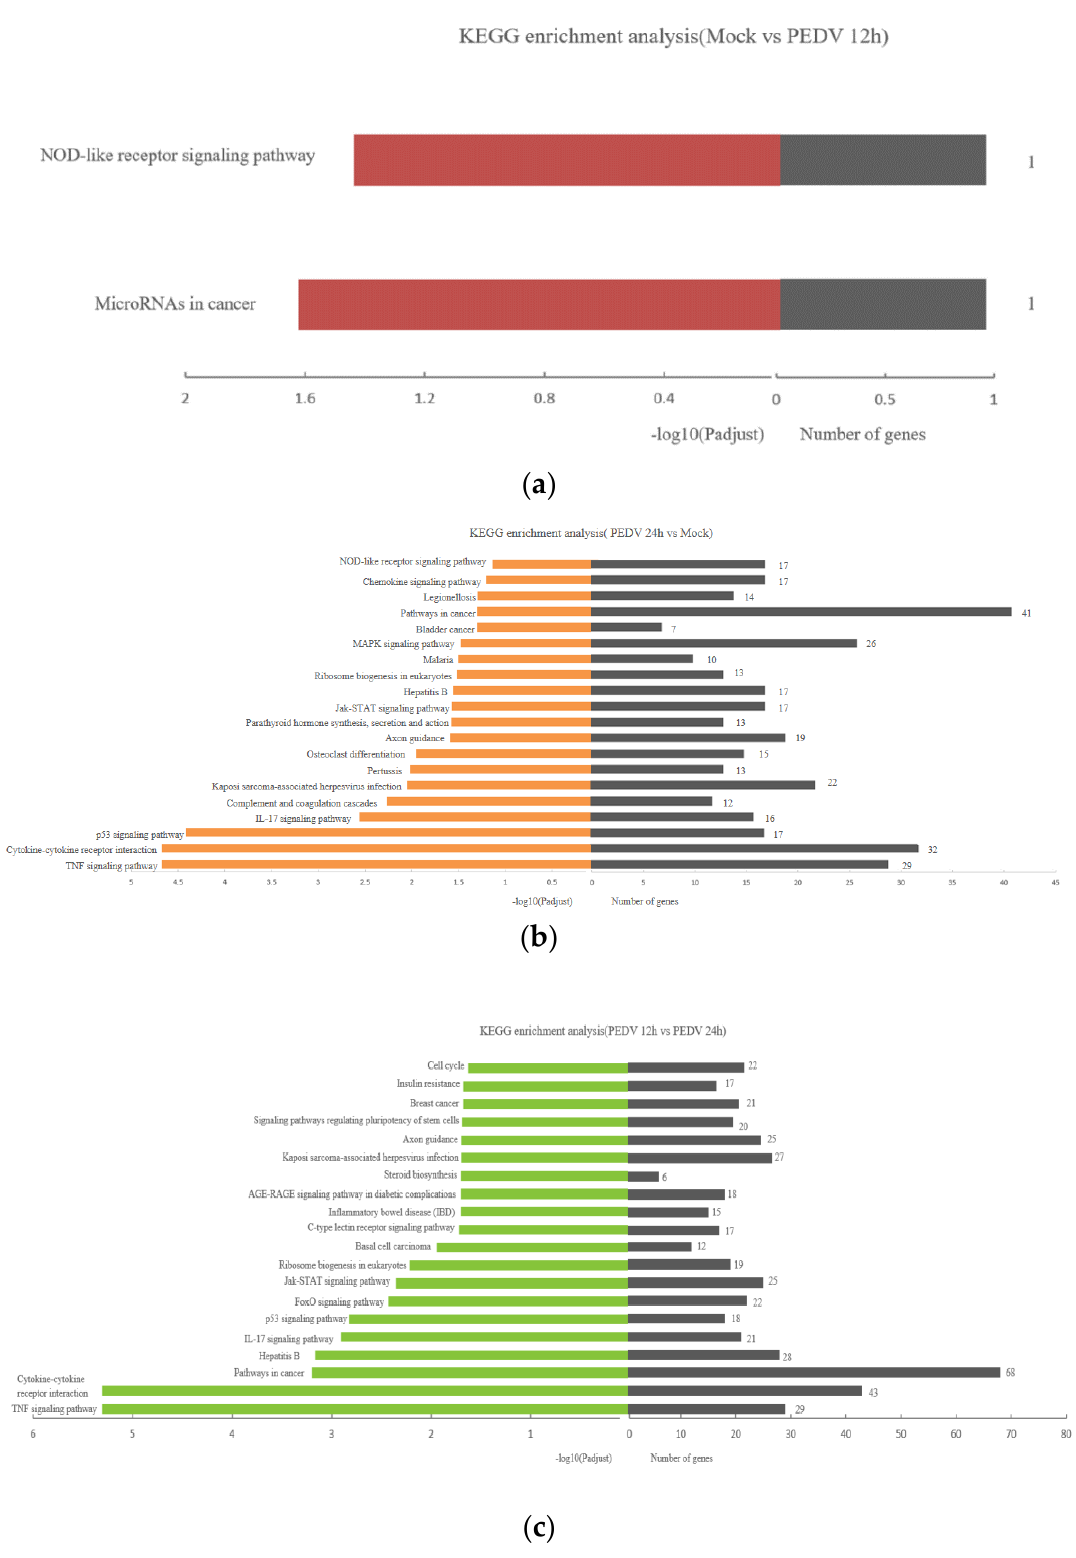
Figure 4. KEGG enrichment map of differentially expressed genes of Mock vs PEDV 12 h ( a ) Mock vs PEDV 24 h ( b ) and PEDV 12 h vs PEDV 24 h ( c ).